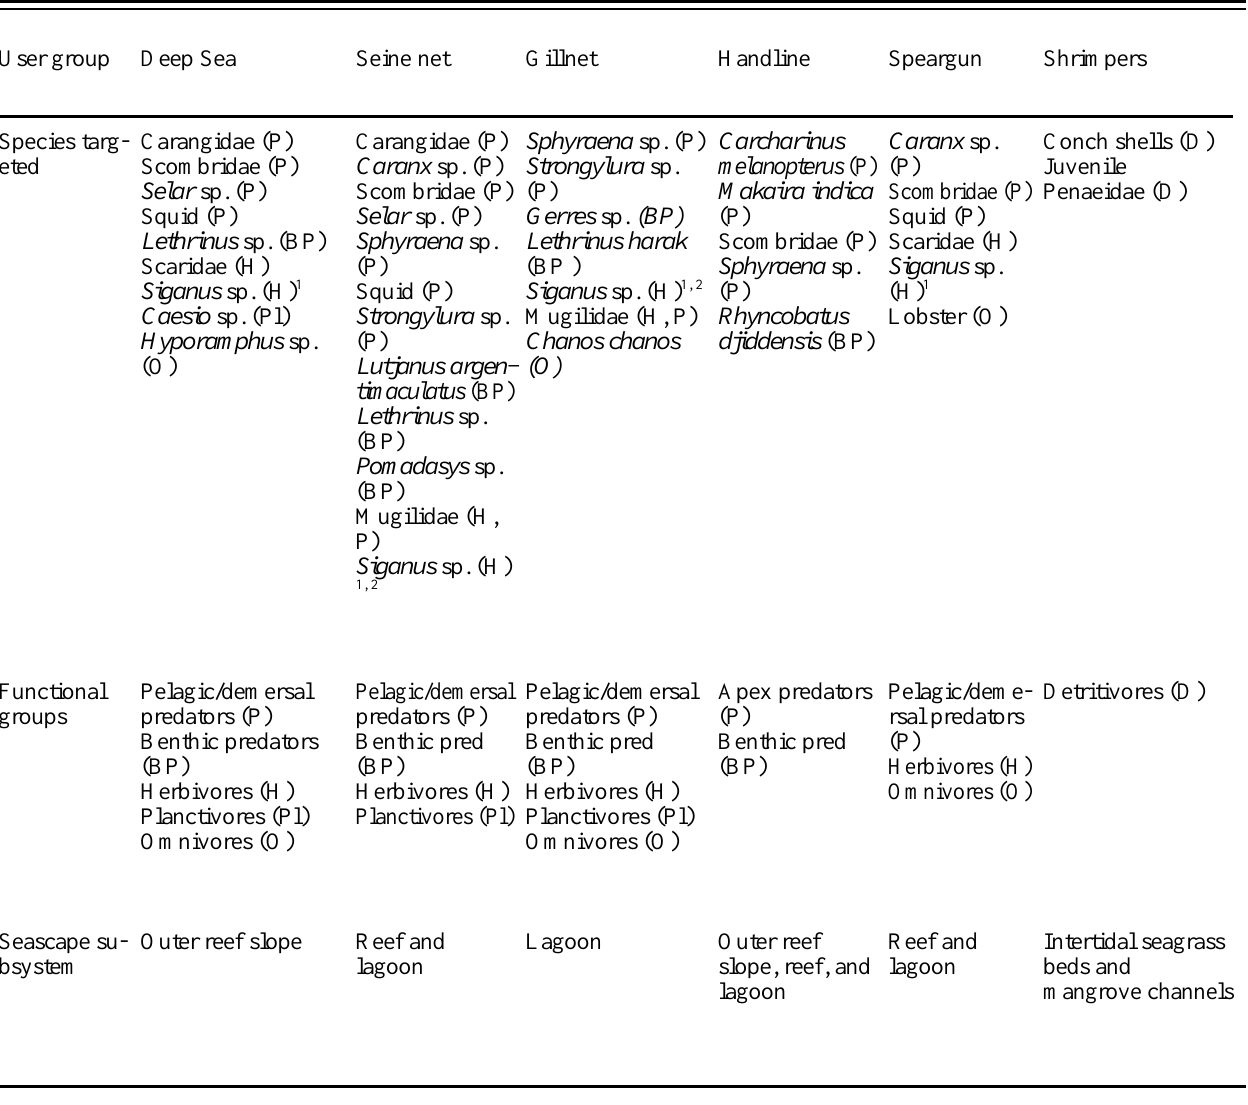
Table 1. Species targeted by fishermen using differing gear types and operating within distinct subsystems of the coastal seascape. Functional groups of target organisms are based on trophic level. Dietary preferences and trophic level are based on Froese et al. (2004). 1 = reef associated 2 = seagrass